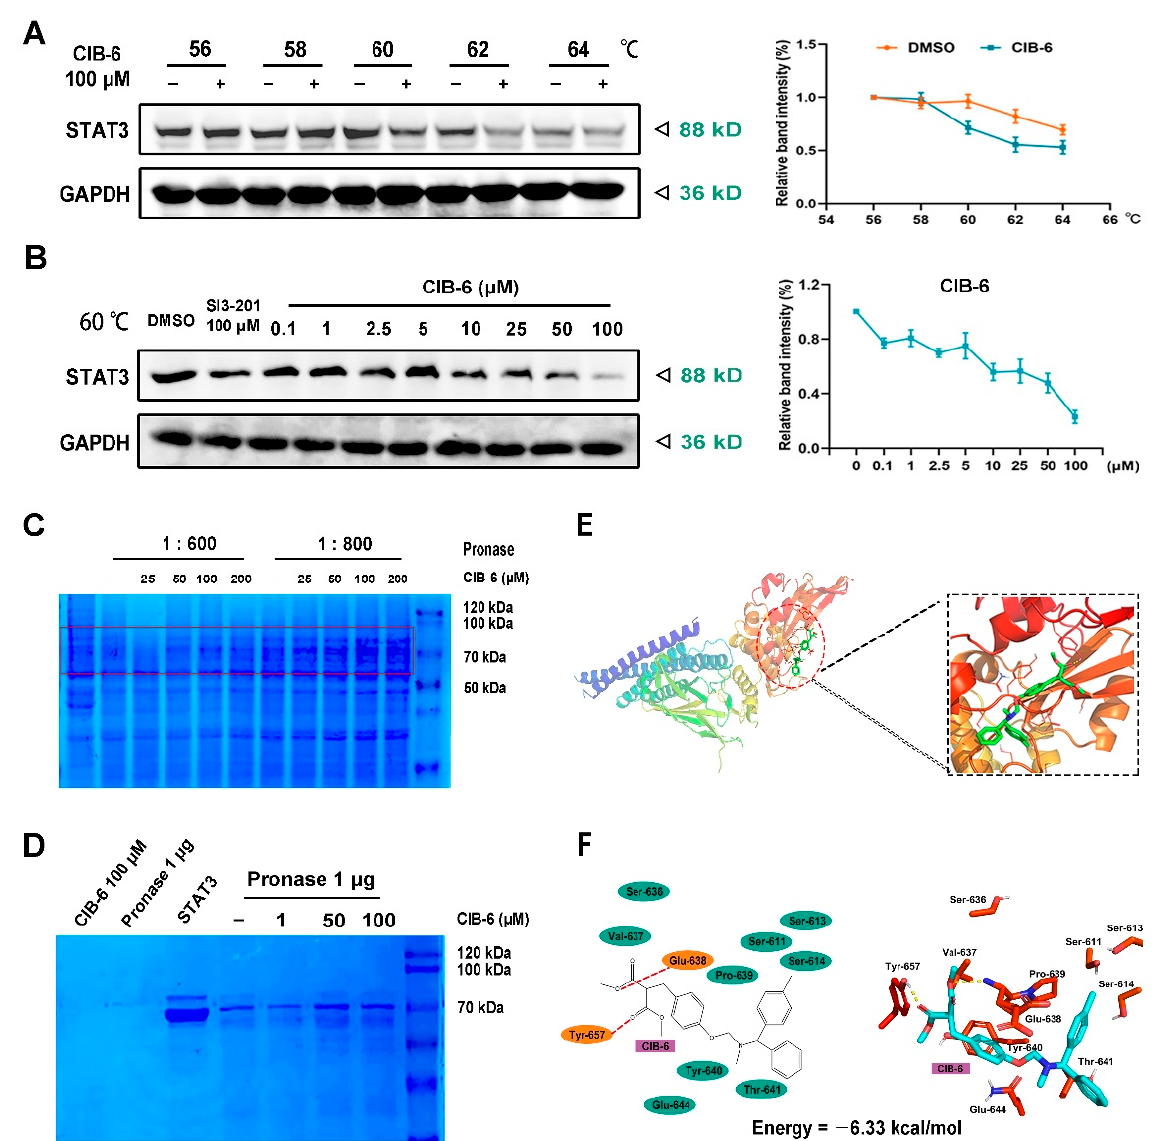
Figure 3. CIB-6 directly interacts with STAT3. The stabilization effect of CIB-6 on STAT3 in SK-HEP-1 lysates was evaluated by Cell Thermal Shift Assay (CETSA) at different temperatures ( A ) and different concentrations ( B ). GAPDH was employed as the loading control. The ordinate in the quantification line chart is the percentage of the relative gray value. Graphic data were run in triplicate and are presented as mean ± SD. SDS-PAGE Coomassie-staining confirmed the stabilization of STAT3 by CIB-6 in SK-HEP-1 cell lysates (pronase: STAT3 1:600 or 1:800) ( C ) as well as the stabilization of pure recombinant expressed STAT3 protein (pET15b-STAT3 ( ∆ 127-722)) by CIB-6 (pronase: STAT3 1:800) ( D ) after pronase digestion in the Drug Affinity-Responsive Target Stability (DARTS) assay. ( E ) Overview of the binding mode of CIB-6 (green) at the STAT3 crystal structure (Protein Data Bank (PDB) ID: 6NJS). ( F ) Two-dimensional (2D) interaction diagram shows all amino acids in the STAT3 SH2 domain active site involved in the formation of H-bonds and hydrophobic interactions with CIB-6.